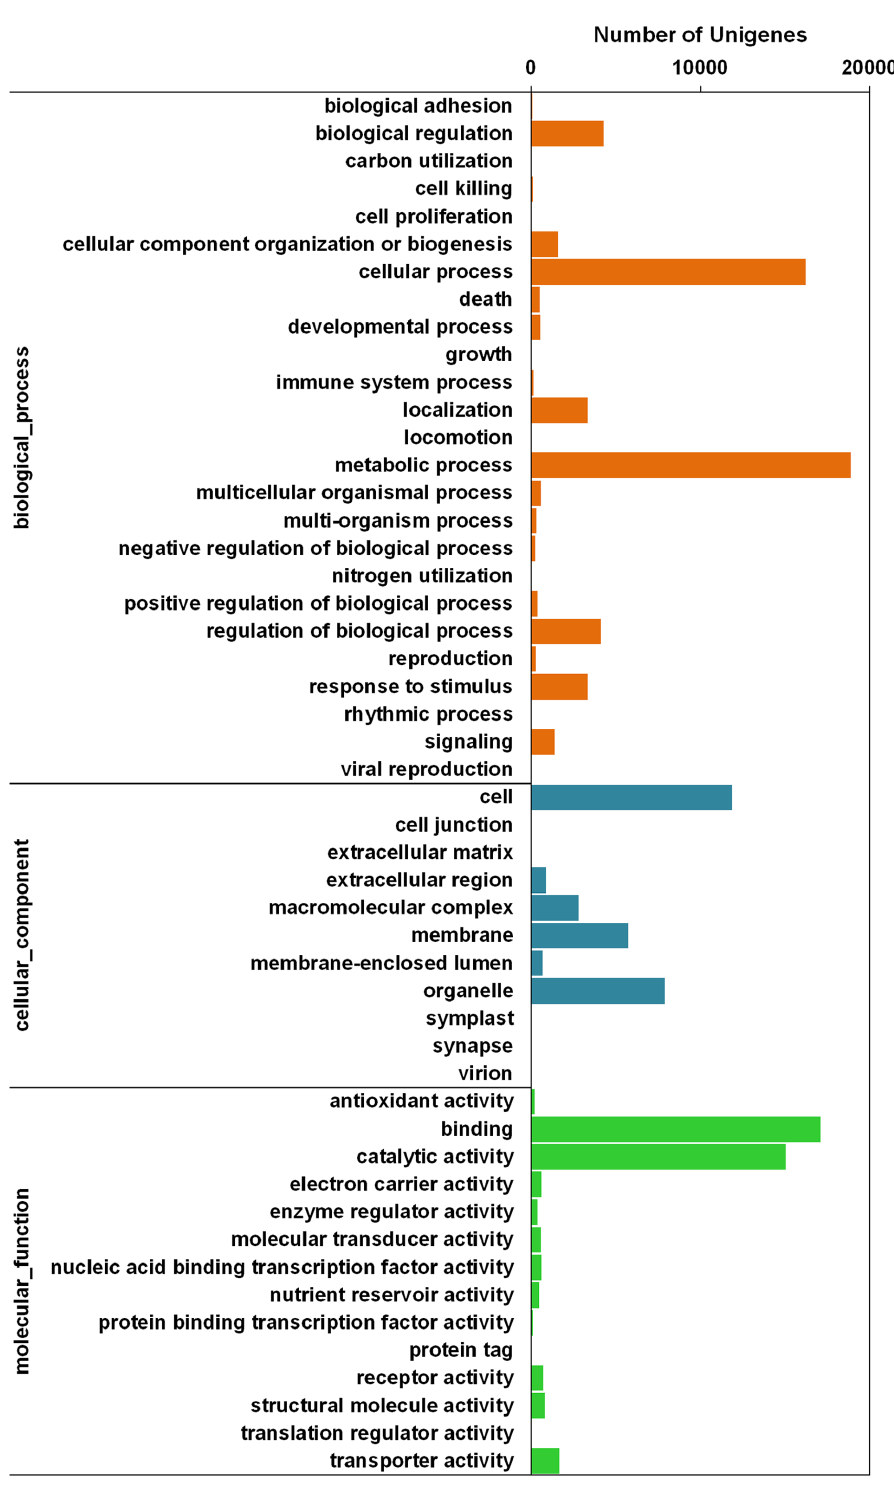
Figure 3. Gene Ontology (GO) categories assigined to the yellow horn unigenes. doi:10.1371/journal.pone.0074441.g003 D 15 or D 6) in fatty acids that are esterified to a glycerol backbone [59], including D 12( v 6)-Desaturase (FAD2 and FAD6, EC:1.14.19.-), which desaturates oleic acid (18:1) to form linoleic acid (18:2), D 15( v 3)-Desaturase (FAD3, FAD7 and